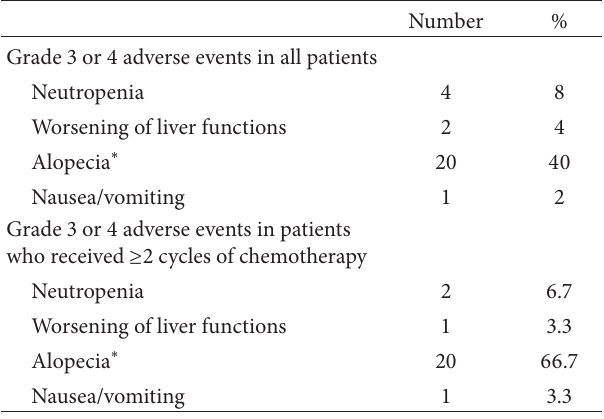
Table 4: Toxicity from treatment. Table 5: Reasons for discontinuation of intra-arterial chemother-